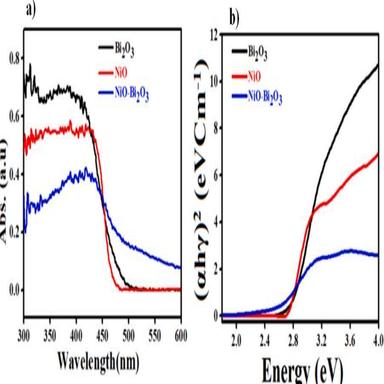
a) UV–Vis-DRS spectra and b) Tauc plots of pure NiO, Bi2O3 and NBO materials.